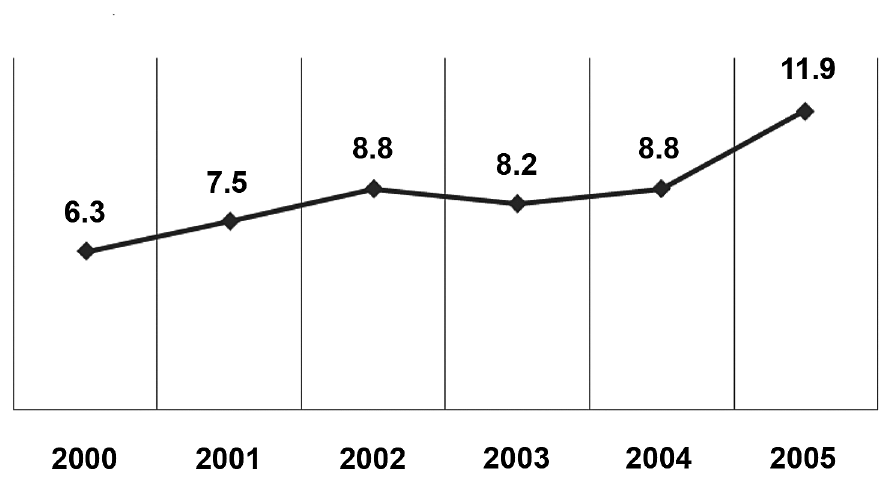
Figure 1 – Mean prostate core biopsies per